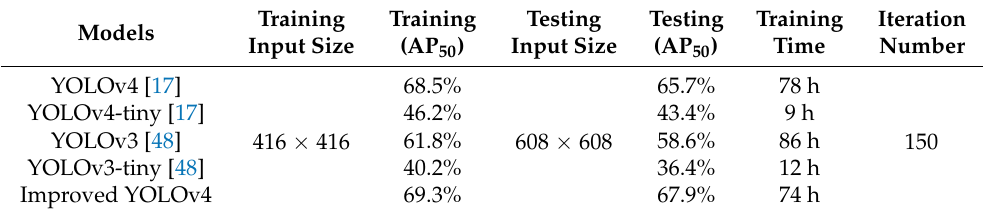
Table 4. Accuracy of models with original fire images (6000 images).